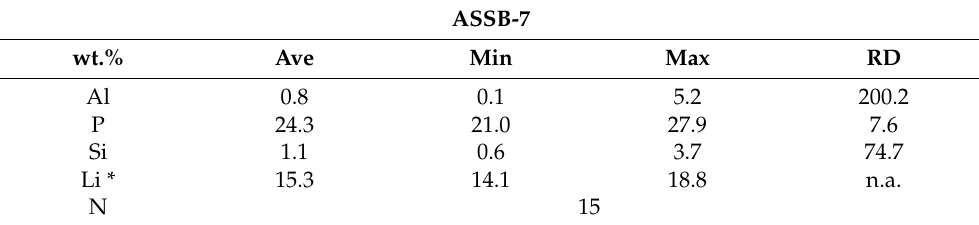
Table A3. Composition of LiP (wt.%) based on single-point analysis (only in ASSB-7). Ave.: arith- metic average; Min./Max.: lowest/highest measured values; RD: relative standard deviation (%); * calculated value; N: number of measurements; n.a. not applicable (calculated values).